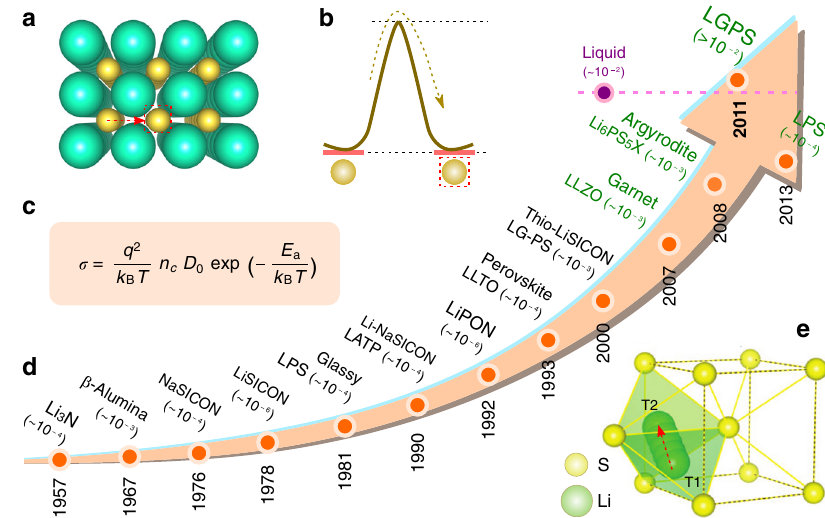
Fig. 3 Quest for highest Li-ion conductivity in inorganic solids. The overall equation de fi ning the ionic conductivity σ is shown together with a schematic of the activation energy barrier corresponding to the hopping of ions from site to site within the crystal structure ( a , b ) together with the most favorable migration path between two tetrahedral sites T 1 and T 2 in the b.c.c. anionic structure ( c ). Development of solid electrolytes over times together with their superionic conductivities (in S·cm − 1 ) indicated in the parentheses ( d ). The legend: NaSICON: Na 3 Zr 2 PSi 2 O 12 ; LiSICON: Li 14 ZnGe 4 O 16 ; Glassy LPS: Li 2 S – P 2 S 5 ; LATP: Li 1.3 Al 0.3 Ti 1.7 (PO 4 ) 3 ; LiPON: Li 2.98 PO 3.30 N 0.46 ; LLTO: Li x La 2/3 − x/3 TiO 3 ; LG-PS: Li 4 – x Ge 1 – x P x S 4 ; LLZO: Li 7 La 3 Zr 2 O 12 ; LGPS: Li 10 GeP 2 S 12 ; LPS: Li 3 PS 4